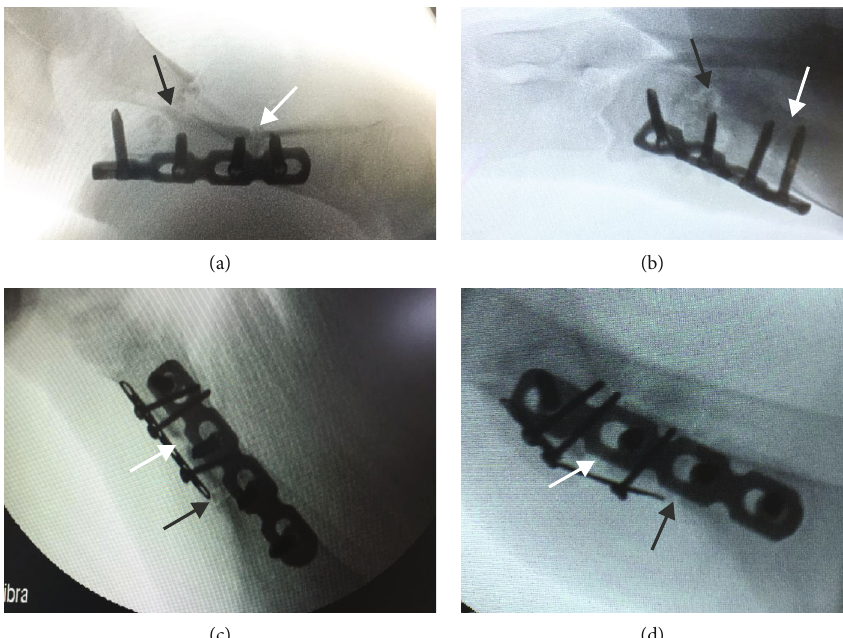
Figure 3: Models of defects C, A1, and A2 and radiography. Time-dependent radiological changes in the defect, 4 and 8 weeks after reconstruction. (a) 4 weeks after reconstruction, the Tibia 1 showing failed defect C (black arrow) and callus formation between the cortex gap of defect A1 (white arrow). (b) 8 weeks after reconstruction, much more callus connecting two ends of defect A1. (c) 4 weeks after reconstruction, the Tibia 2 showing more callus formation in control defect C (black arrow) than in treatment defect A2 (white arrow). (d) 8 weeks after reconstruction, broken plate happens, whereas more callus in defect C.